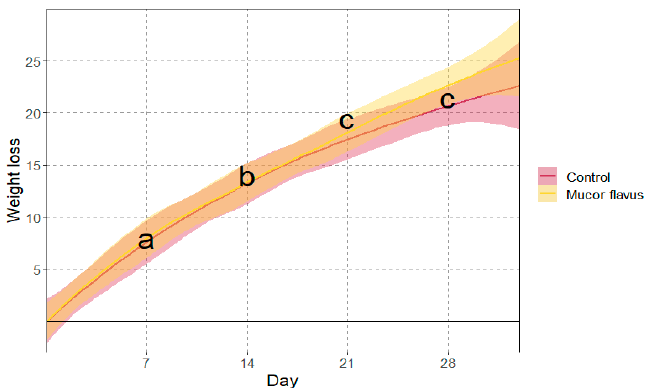
Figure 1. Weight loss of meat during dry-aging with and without biostarter. The orange and red shadows around lines stand for 95% confidence interval ; a, b, c—means marked with different let- ters differ significantly at p < 0.05.